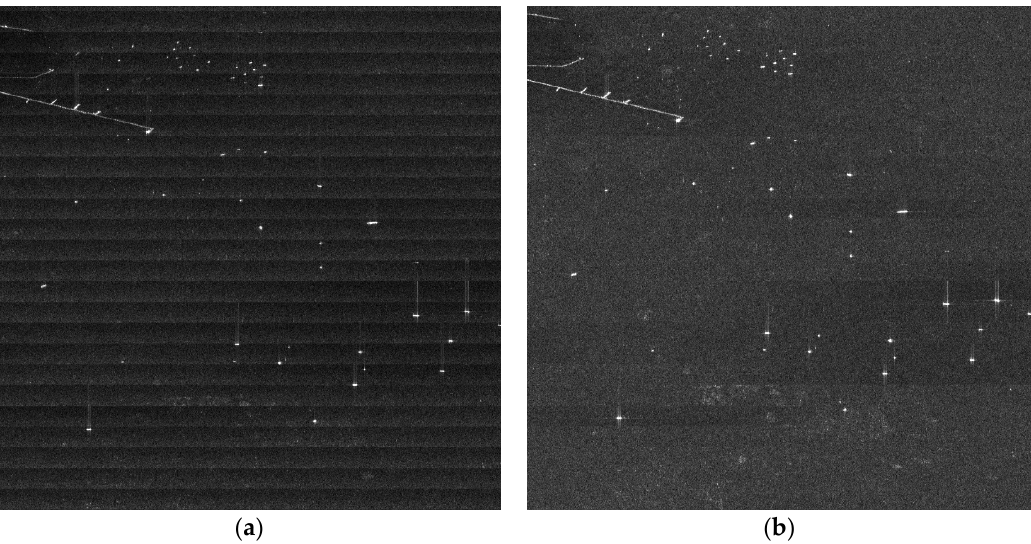
Figure 21. Descalloping effect of ships: ( a ) before descalloping; ( b ) after descalloping.